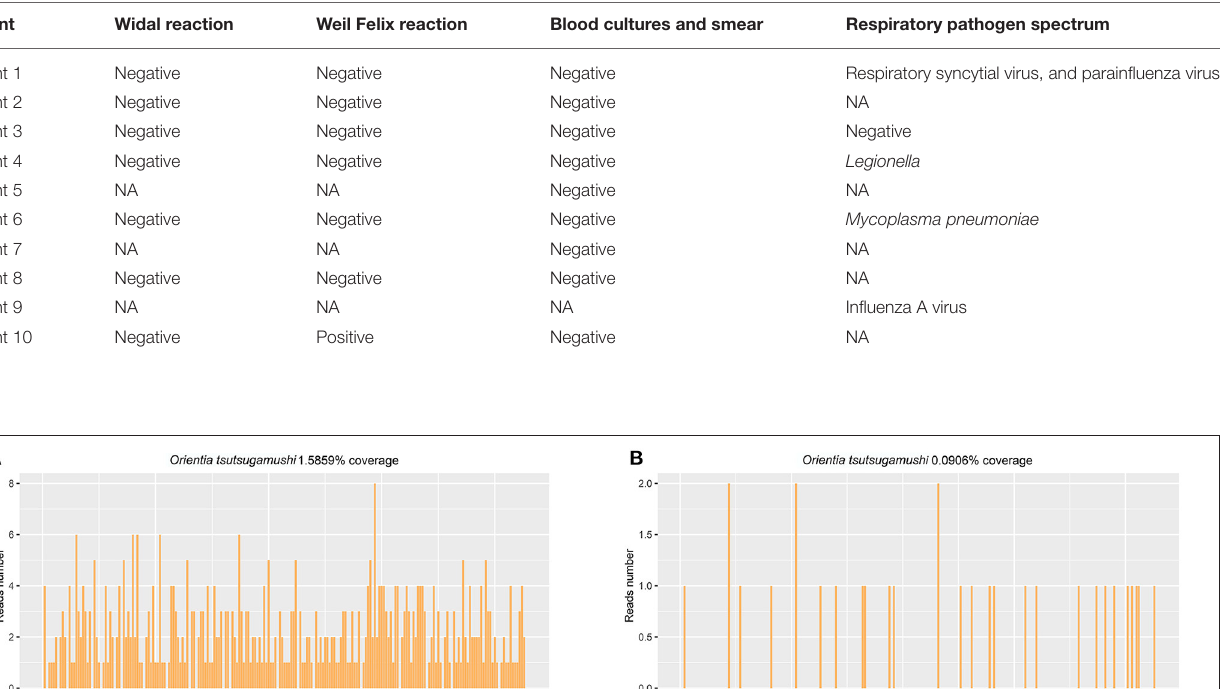
TABLE 2 | The results of diagnosis by different methods.